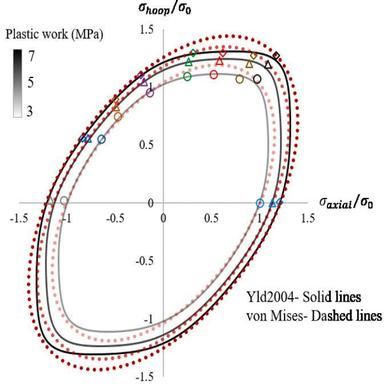
AA7075-O extruded tube's normalized yield stress surface evolution for different plastic work levels.